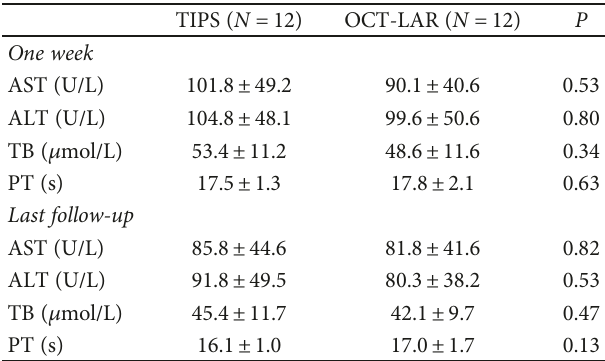
Table 5: Live functions at one week and last